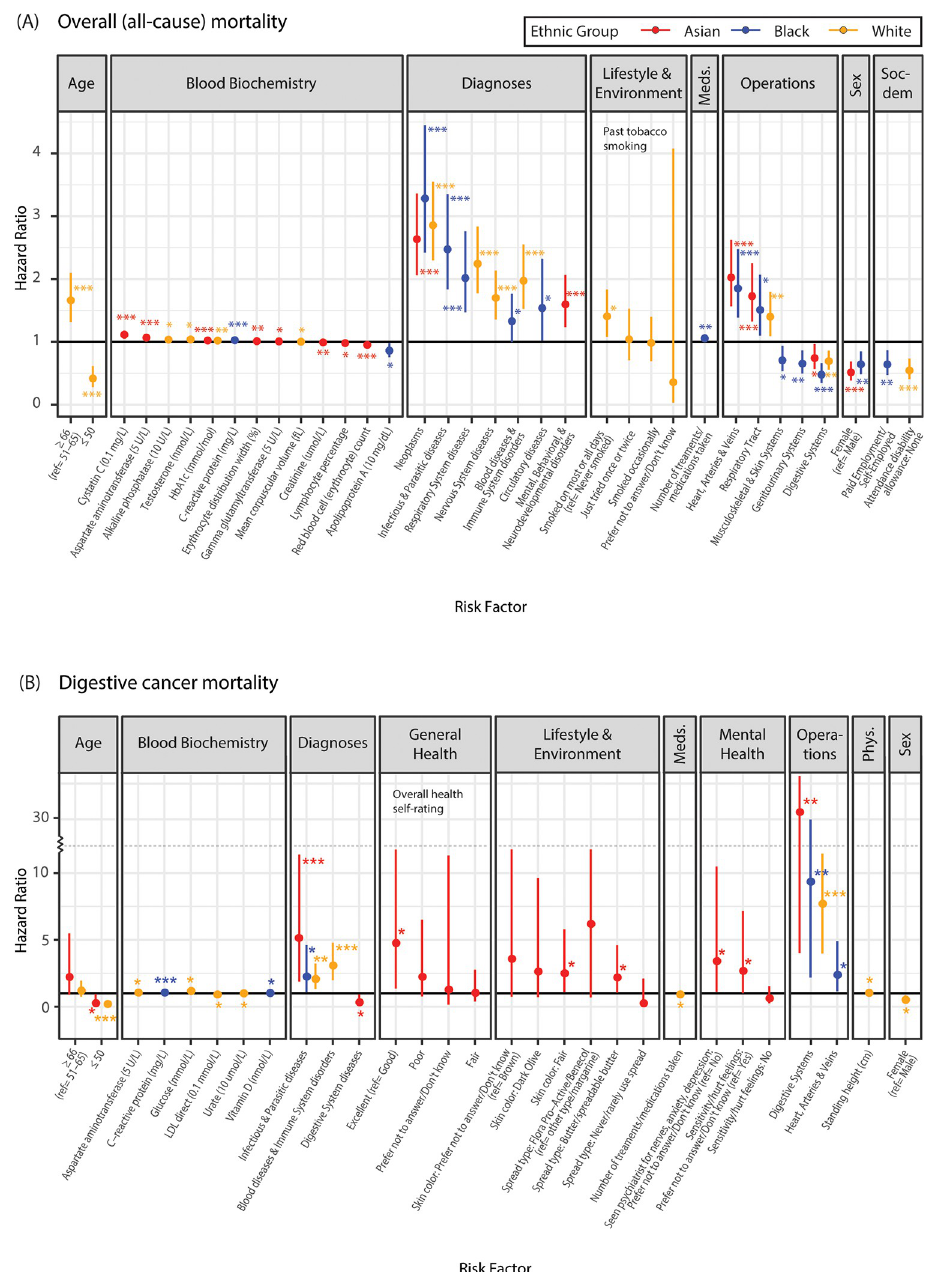
Fig 3. Ethnicity and mortality risk factors. Risk factor-mortality associations, as measured by Cox proportional hazard ratios (with 95% CIs), are shown for Asian (red), Black (blue), and White (yellow) ethnic groups. Significance of association measured in p-values are indicated in stars. Associations are shown for (A) overall (all-cause) mortality and (B) digestive cancer mortality. Mortality risk factor categories include: age, blood biochemistry, previous in- patient disease diagnoses (diagnoses), lifestyle and environmental measures, medications (meds.), previous in-patient operations and/or procedures (operations), sex, sociodemographic factors (soc-dem), general health, mental health, and physical measures